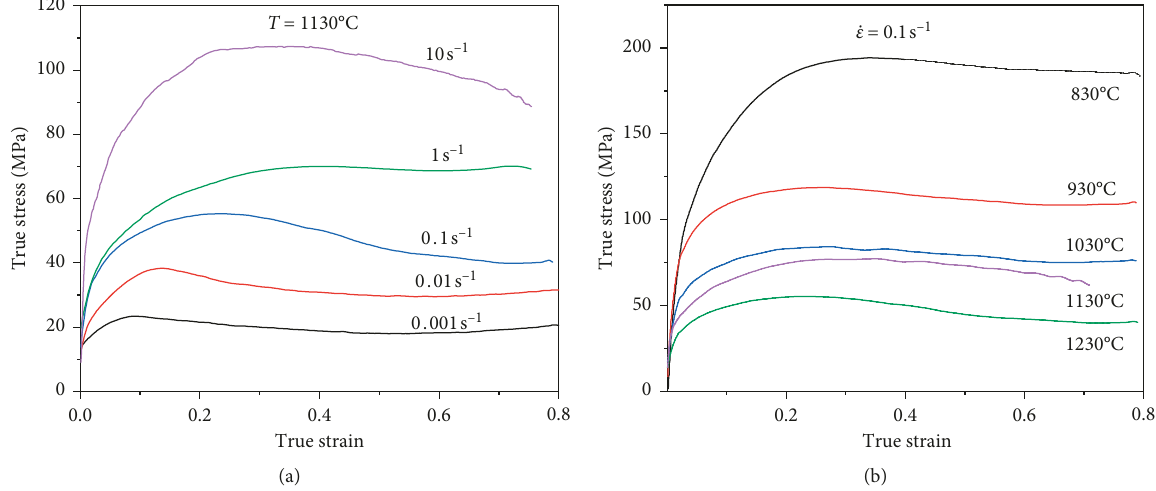
Figure 2: Typical true stress-strain curves of hot work die steel 5CrNiMoV at different deformation conditions.